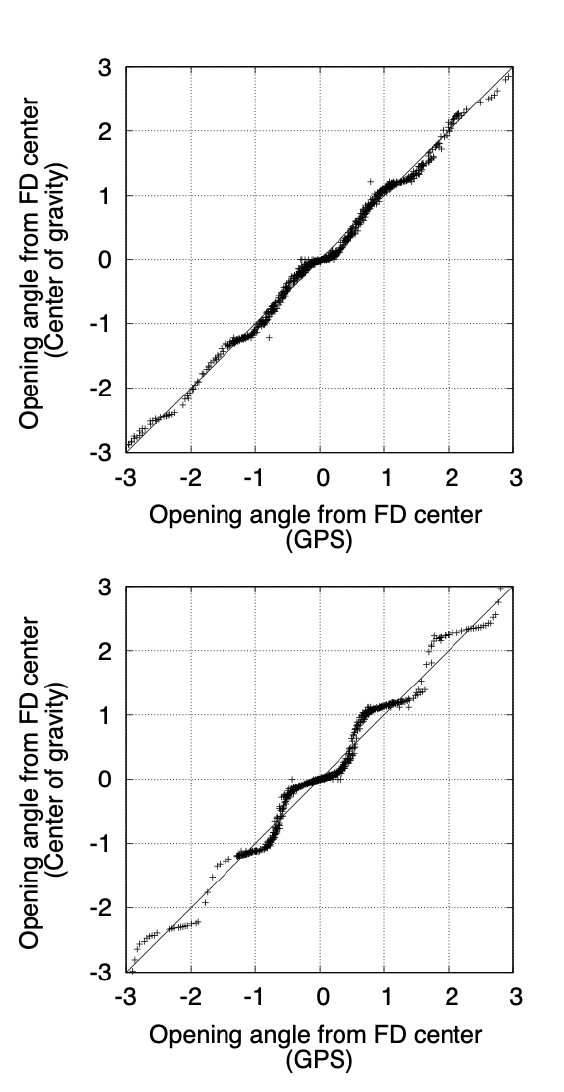
Figure 12. Correlation of opening angle from the center of field of view of RTK-GPS and FD of detection center of gravity in two